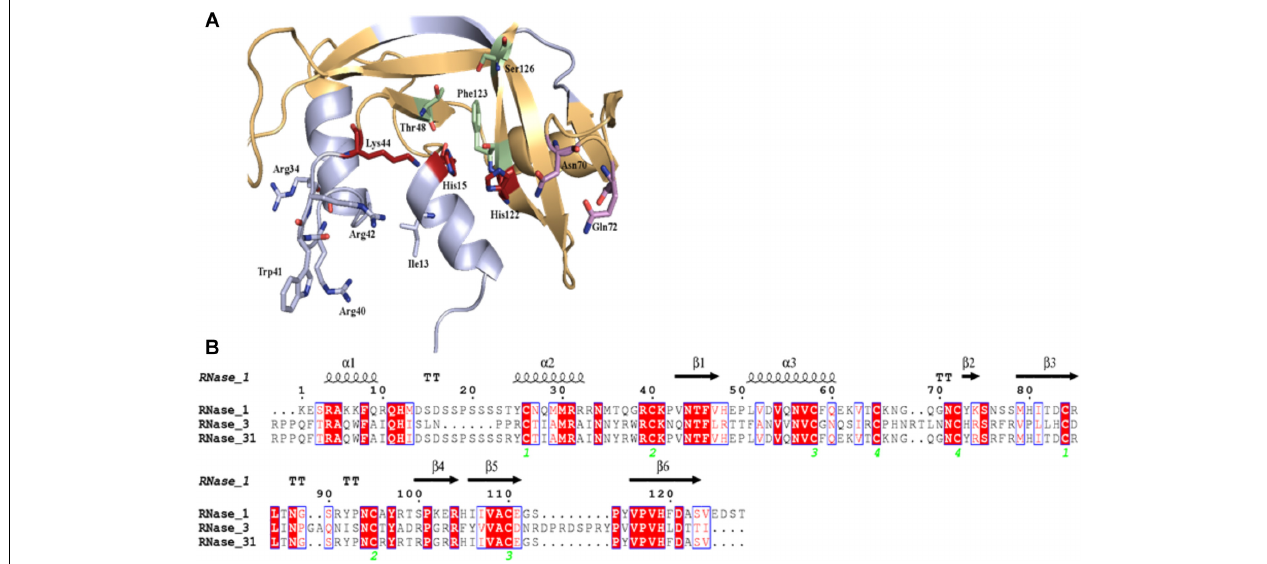
FIGURE 1 | Design of RNase3/1 chimera. (A) Model of RNase 3/1 obtained by Modeler 9.12 (Webb and Sali, 2016). In green, B1 site. In pink, B2 site. In red, the active site. In beige, the RNase 1 skeleton. In light blue, the RNase 3 antimicrobial regions. (B) Alignment of RNase 1, 3 and 3/1 primary structures. The fully conserved amino acids are highlighted in red. The residues that are not conserved but have similar properties are marked with red letters. The secondary structure is indicated above the alignment. The green numbers indicate the disulphide bridge pairs. The alignment was done using Clustal Omega (Sievers and Higgins, 2018), and the image was obtained with ESPript7 (http://espript.ibcp.fr/ESPript/) (Robert and Gouet, 2014).